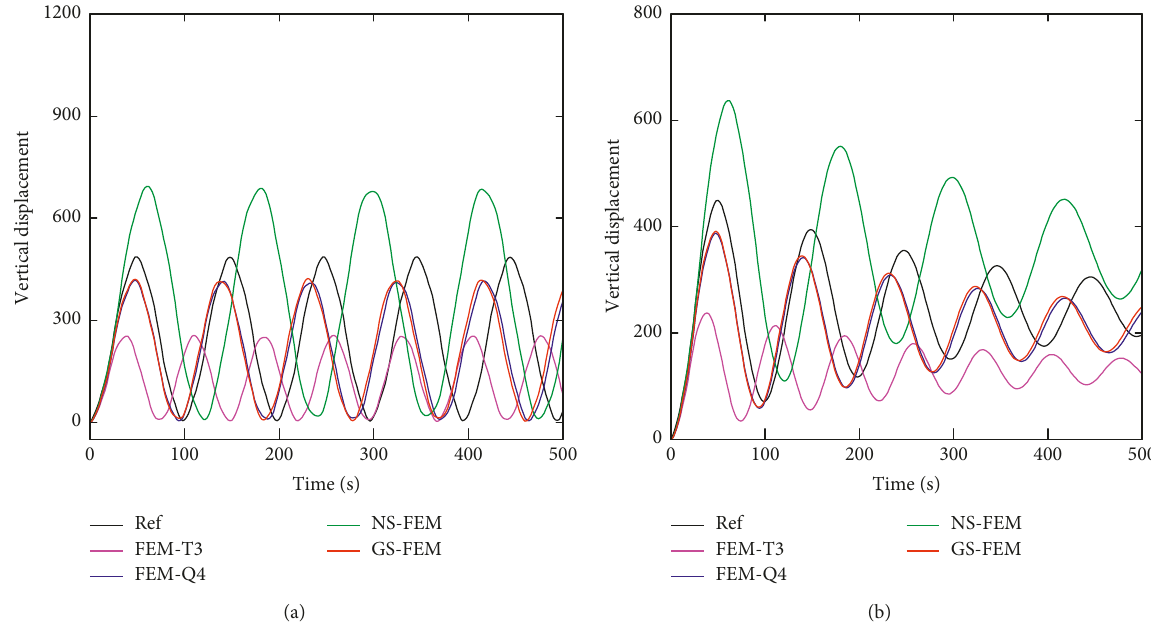
Figure 32: Transient response of the cantilever beam subjected to constant step loading: (a) without damping; (b) with damping.